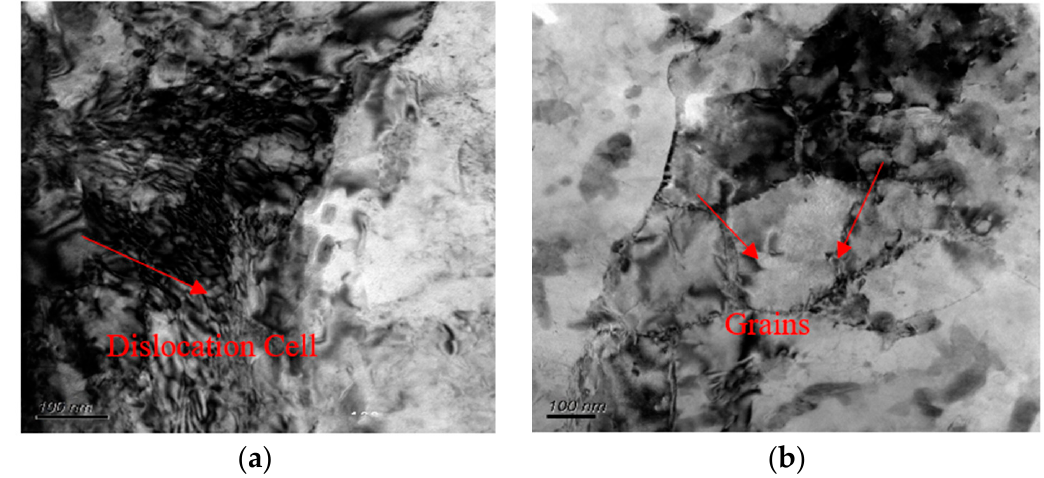
Figure 9. TEM image of the AWJP + USRP sample ( a ) at a depth of 200 µ m and ( b ) a depth of 150 µ